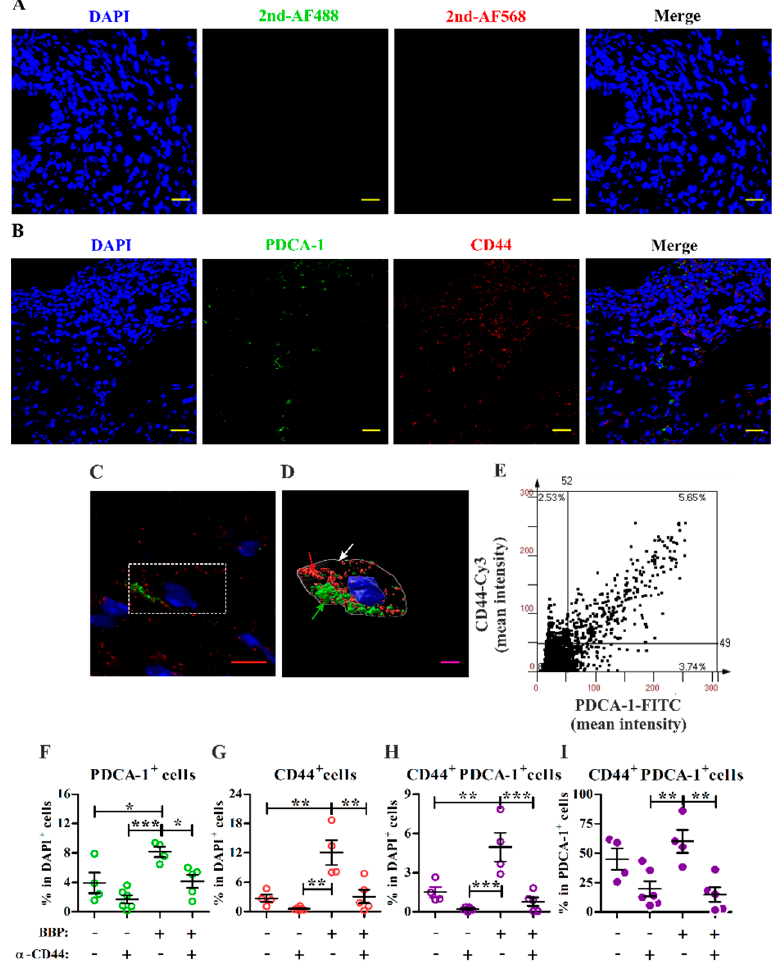
Figure 5. Identification of CD44-expressing pDCs and the effect of a CD44 blocking antibody on the pDC subset in endometriotic lesions. Representative immunofluorescence images of endometriotic lesion sections from one BBP-treated mouse. Lesion sections were stained with secondary antibodies alone ( A ) and with primary antibodies (PDCA-1 and CD44) and secondary antibodies ( B ), showing PDCA-1 + , CD44 + , and CD44 + PDCA-1 + cells. Scale bars = 20 µm. ( C ) The immunofluorescence image of one representative CD44 + PDCA-1 + cell, as shown in the dashed white box. Scale bar = 5 µm. ( D ) The image of the representative cell shown in ( C ) was captured by confocal z-stack scanning and was remodeled as a three-dimensional structure in a basic way showing PDCA-1 (green arrow) and CD44 (red arrow) expression with respect to the putative cell membrane (white arrow). Scale bar = 3 µm. ( E ) A representative dot plot is shown for quantification of PDCA-1 + , CD44 + , and CD44 + PDCA-1 + cells from immunofluorescence images of an intact BBP-treated endometriotic lesion. The x -axis shows the mean fluorescence intensity of PDCA-1, and the y -axis indicates CD44 fluorescence. ( F – I ) The frequencies of PDCA-1 + ( F ), CD44 + ( G ), and CD44 + PDCA-1 + ( H ) cells among DAPI + cells and the frequency of CD44 + PDCA-1 + cells among PDCA-1 + cells ( I ) from control and BBP-treated mice were quantified for an entire field from each lesion section. The lesions were collected from each mouse locally treated with blocking monoclonal antibody against CD44 on one side (+) and with an isotype control antibody on the other side ( − ) at the implantation sites. Each data point in ( F – I ) represents one section from one endometriotic lesion, and only one endometriotic lesion was quantified per mouse. The black horizontal lines and error bars represent the mean and SEM for each group, respectively ( n = 4–6 mice/group from two independent experiments). * p < 0.05, ** p < 0.01, and *** p < 0.001 by one-way ANOVA followed by Tukey’s multiple comparison test.